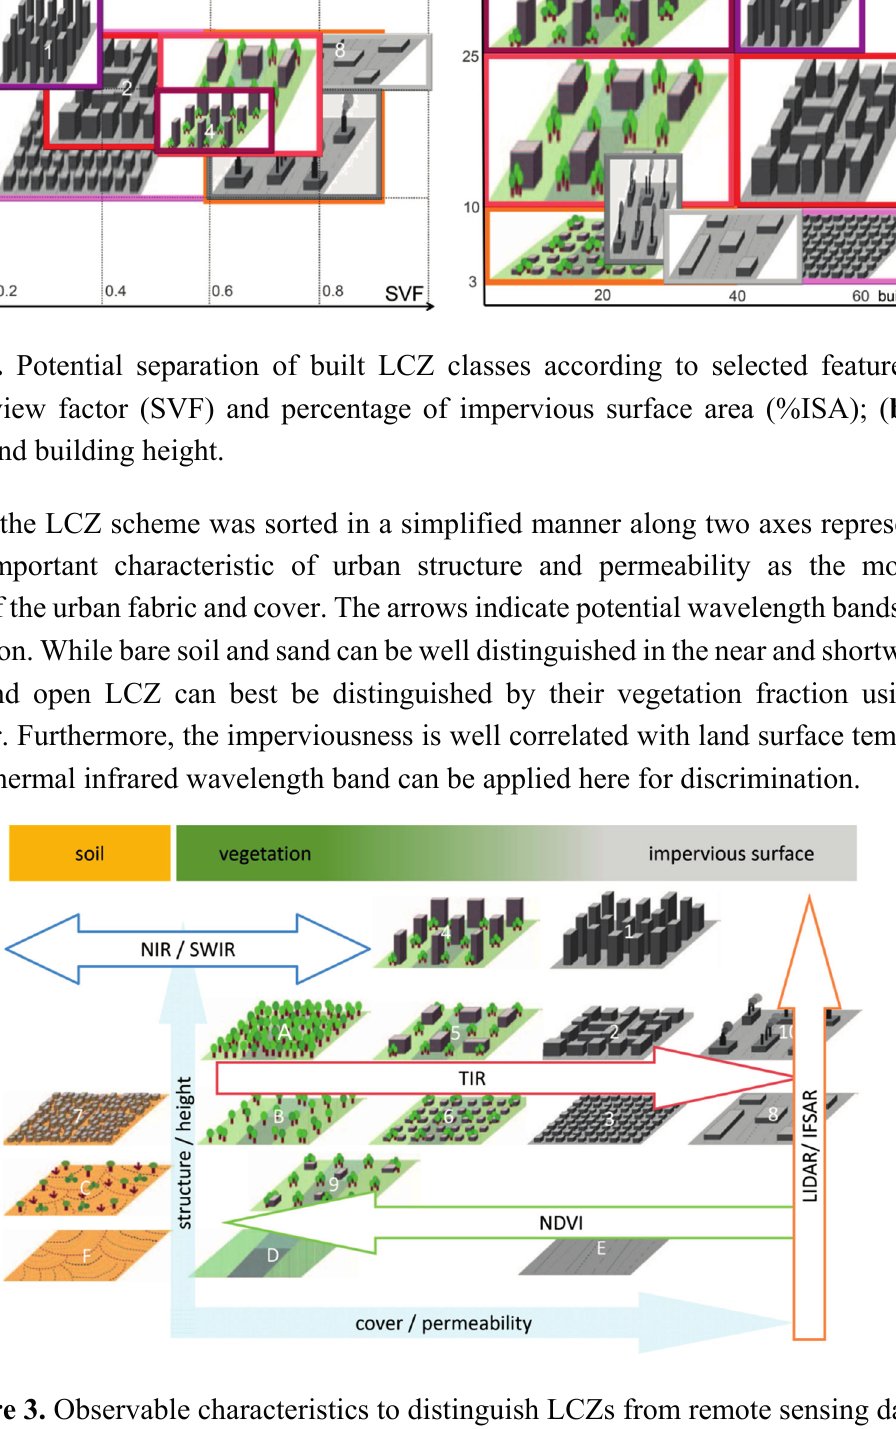
Figure 3. Observable characteristics to distinguish LCZs from remote sensing